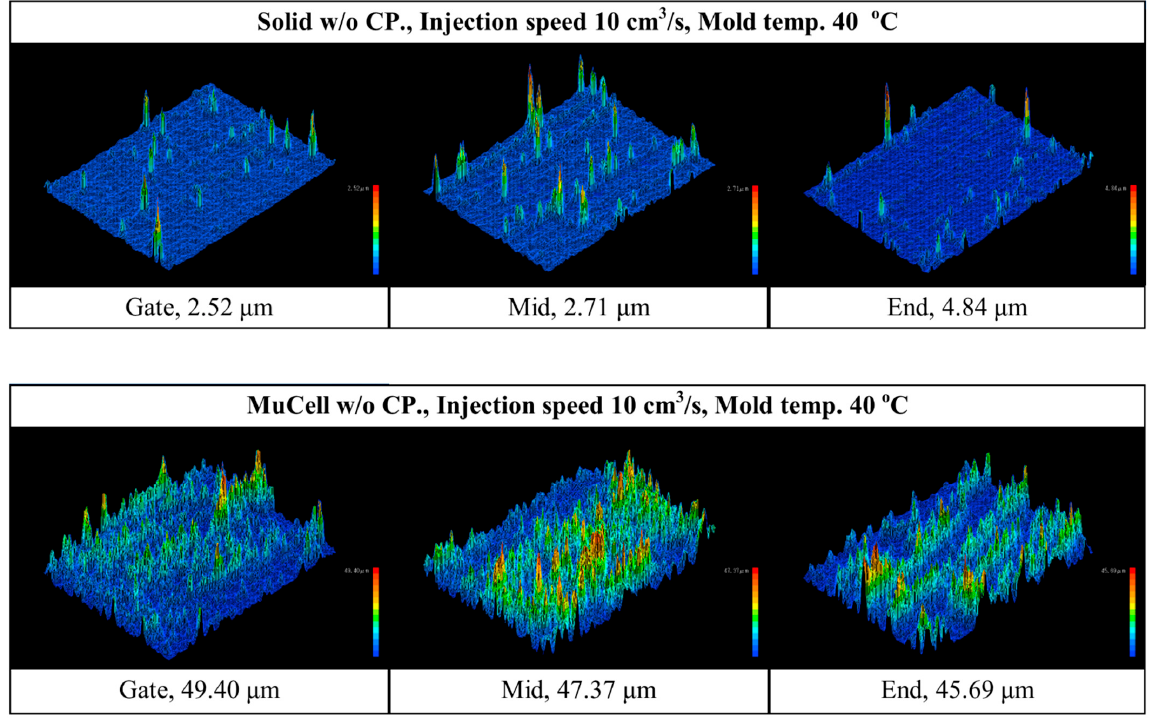
Figure 6. ( a ): Examination locations for parts’ surface roughness; ( b ): a typical SEM micrograph of a foamed sample.